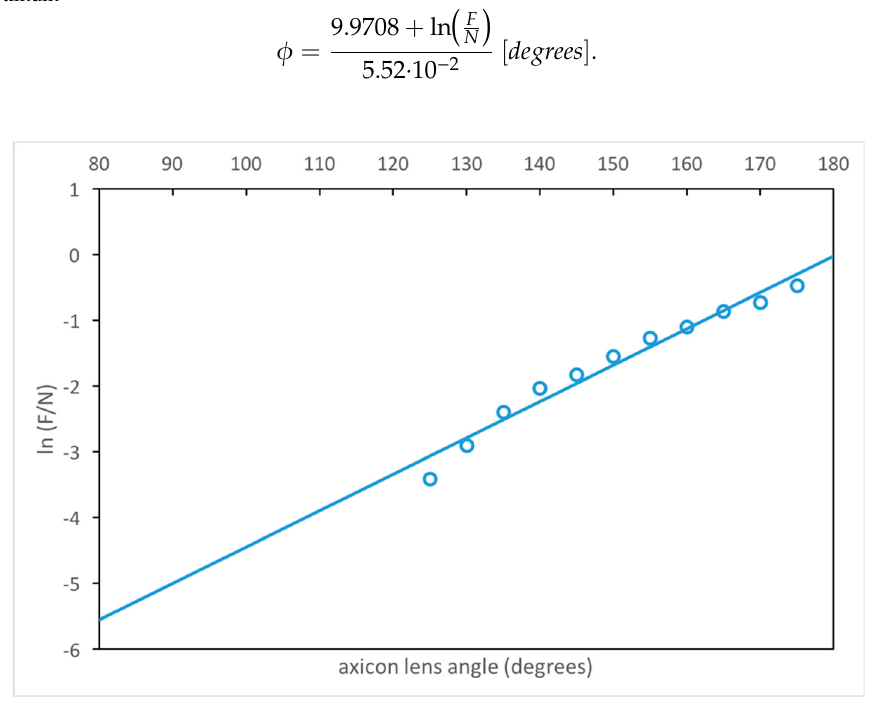
Figure 3. Illustration of the relation between the axicon lens angle φ and the ratio of F/N .